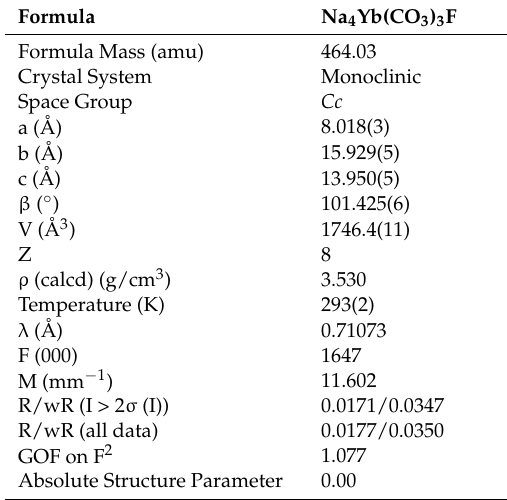
Table 1. Crystal data and structure refinement for Na 4 Yb(CO 3 ) 3 F.